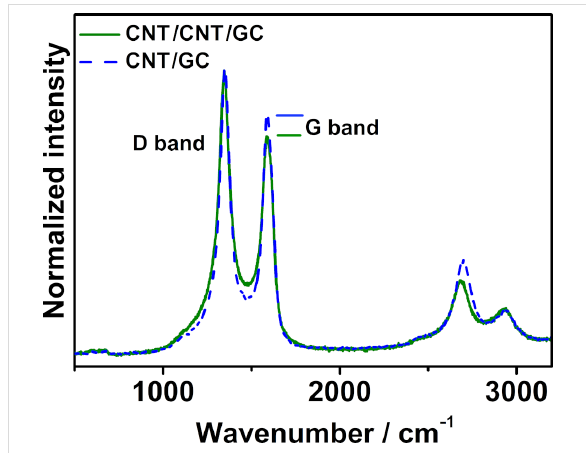
Figure 5: Raman spectra of CNT/GC and CNT/CNT/GC electrodes. The spectra are normalized with respect to the intensity of the D-band, and horizontal lines indicate the height of the